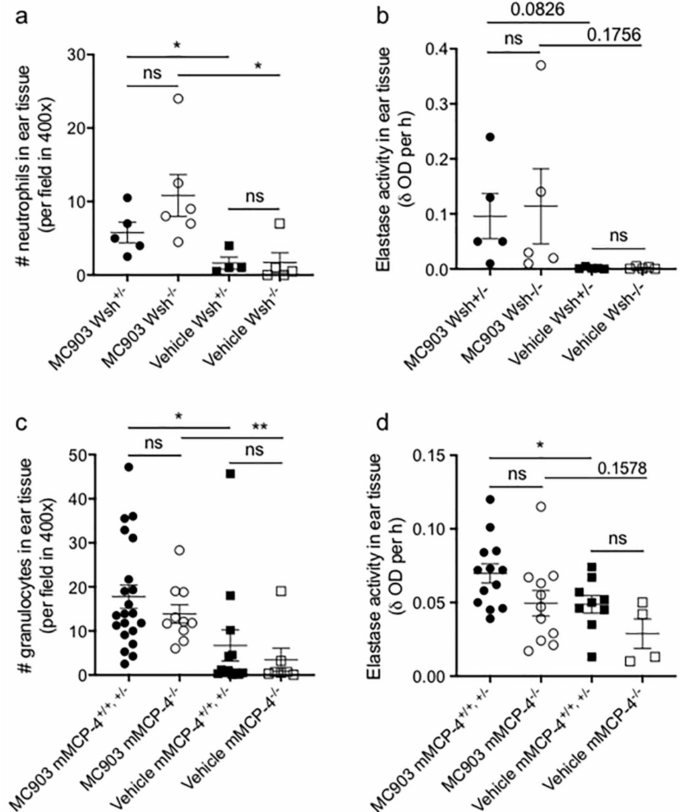
Figure 3. Significant influx of granulocytes to the ear tissue in MC903-induced atopic